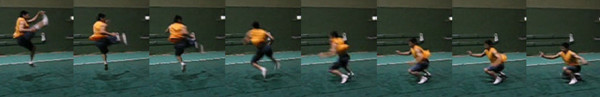
Non-contact anterior cruciate ligament injury.